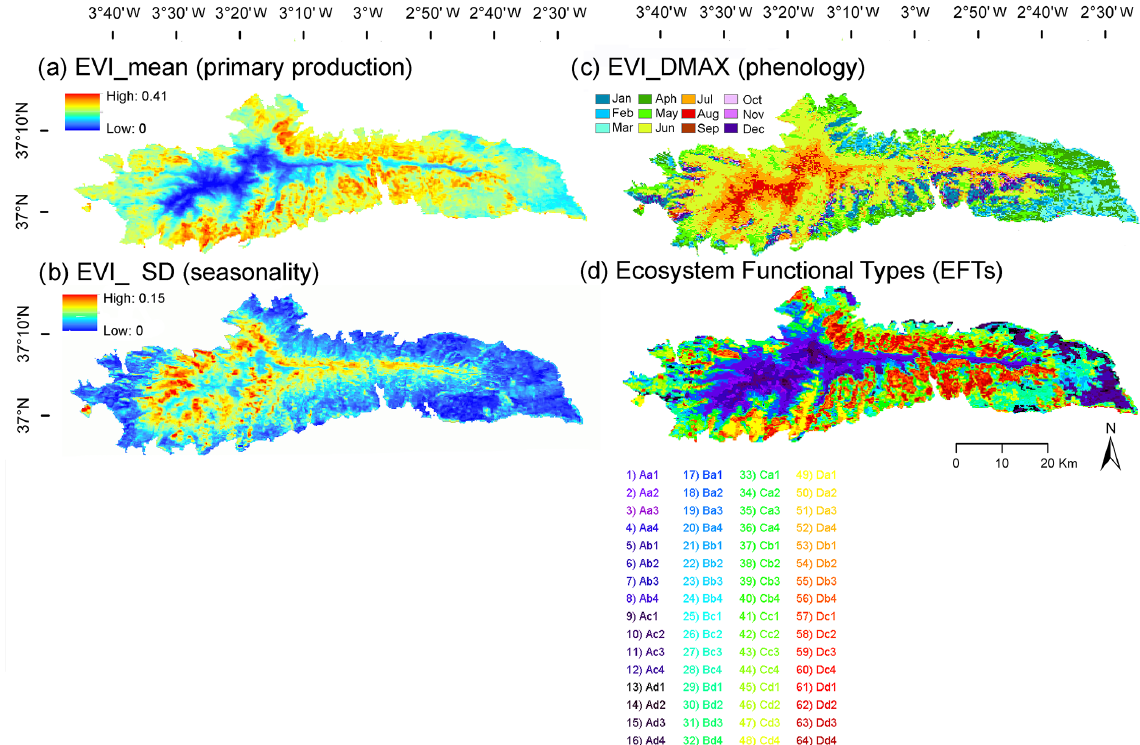
Figure 4. EFAs ( a–c ) and EFTs (d) describing the functioning of the vegetation canopy based on the EVI, derived from MOD13Q1- TERRA (pixel 232m) for the period 2001–2018. EFAs were (a–c) the annual mean of the EVI, an estimator of annual primary produc- tion (EVI_mean), the EVI seasonal coefficient of variation, i.e., a descriptor of seasonality or the differences between the growing and non-growing seasons (EVI_sSD), and the date of the maximum EVI, a phenological indicator of the growing season (EVI_DMAX). To name EFTs (d) , we used two letters and a number: the first, capital, letter indicates primary production (EVI_mean), increasing from A to D, the second, lowercased, letter represents seasonality (EVI_sSD), decreasing from a to d, and finally, the numbers are a phenological indicator of the growing season (EVI_DMAX), with values 1 – spring, 2 – summer, 3 – fall, and 4 – winter (Table 1). The EFT alphanumeric code (Aa1 to Dd4) corresponds to the numeric code (1 to 64) in the .TIF files, as shown in the panel legend (d) .